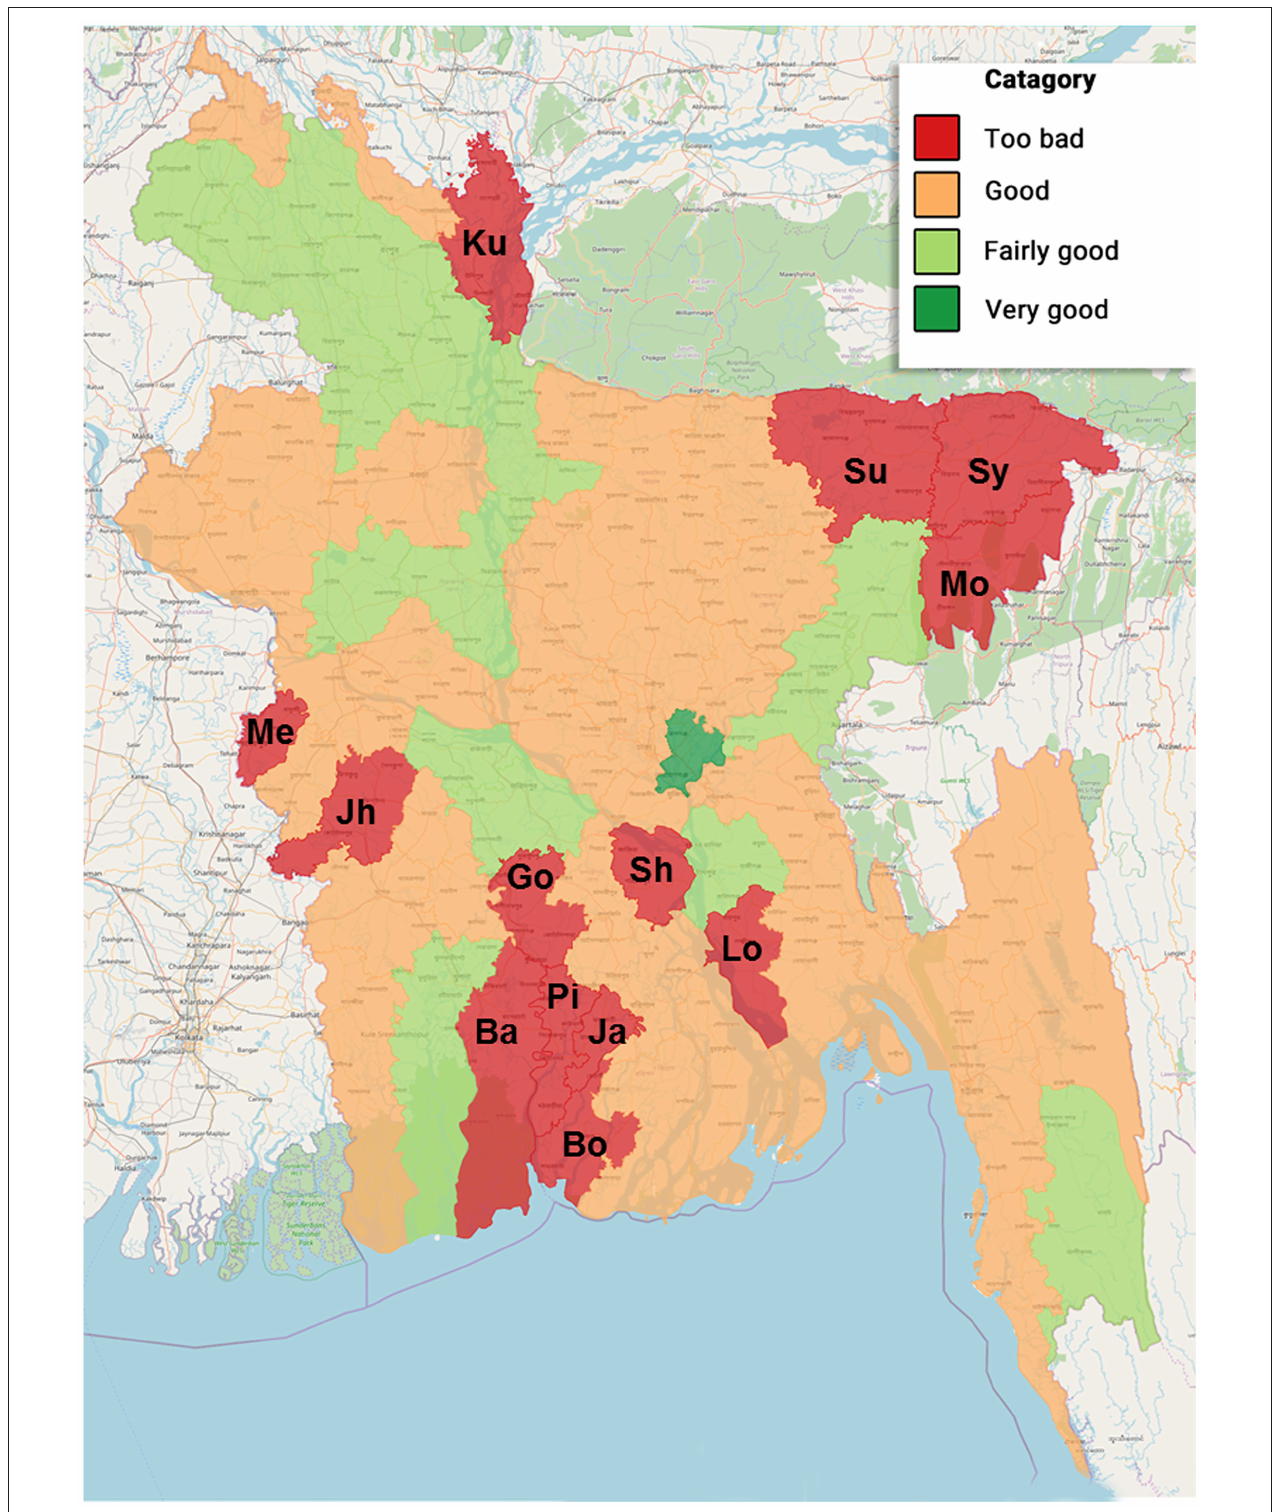
FIGURE 6 | Scenario of social distancing situation in different administrative districts of Bangladesh during 8–14 April 2020 (Ba, Bagerhat; Bo, Borguna; Go, Gopalgonj; Ja, Jhalokati; Jh, Jhenaidah; Ku, Kurigram; Lo, Lakshmipur; Me, Meherpur; Mo, Moulvibazar; Pi, Pirojpur; Sh, Shariatpur; Su, Sunamgonj; Sy, Sylhet).